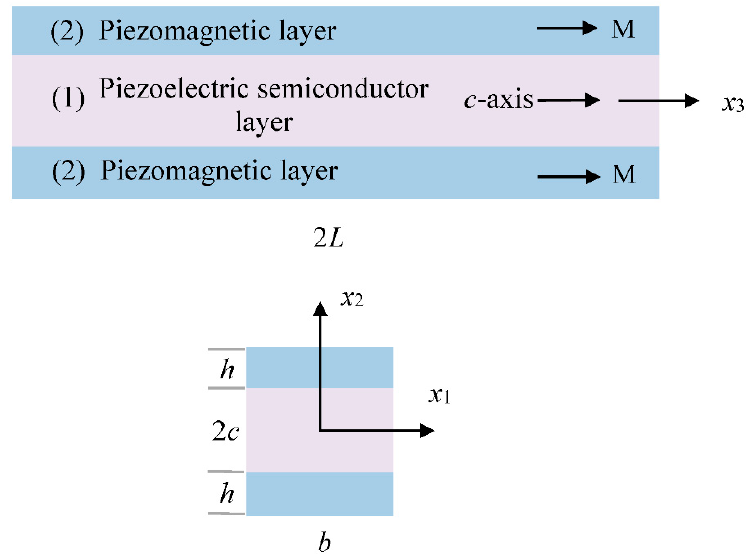
Figure 1. A composite rod of a piezoelectric semiconductor and piezomagnetics.